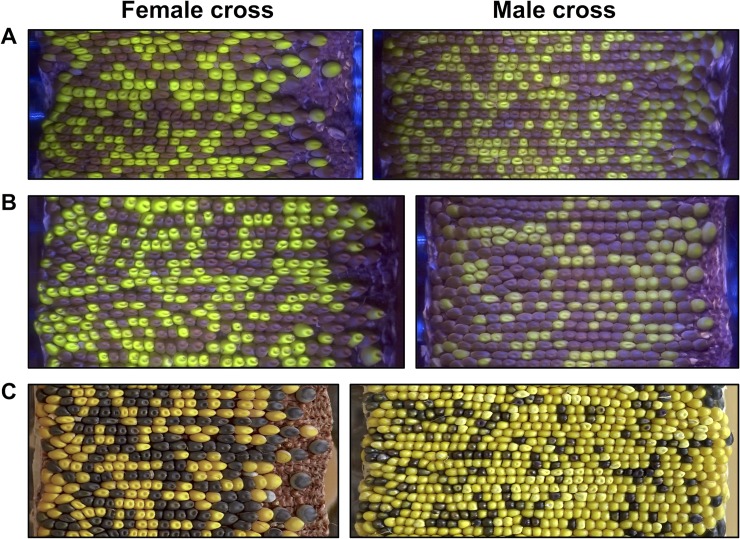
Large-scale tracking of seed marker transmission frequencies was accomplished by generating ear projections with a custom built rotational scanner.(A) When crossed either through the male or the female, Ds-GFP mutant allele tdsgR107C12 (in gene Zm00001d012382), marked by green fluorescent seeds, shows 1:1 Mendelian inheritance (50% transmission of the GFP seed marker). Images captured in blue light with an orange filter. (B) Mutant alleles in other genes, such as tdsgR102H01 (Zm00001d037695), showed non-Mendelian segregation when crossed through the male (37.5% GFP transmission). Segregation through the female remained Mendelian, indicating a male-specific transmission defect. (C) For some mutant alleles (~10% of lines in this study), the anthocyanin transgene C1 was tightly linked to the insertion mutant. In these cases, seeds carrying a mutant allele of a gene of interest could be tracked by their purple color. Here, insertion tdsgR96C12 (Zm00001d015901) shows a strong male-specific transmission defect (24.8% C1 transmission through the male). Images captured in full spectrum visible light.